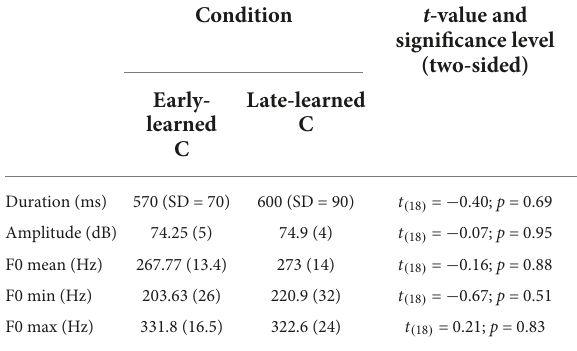
TABLE 2 Experiment 1: acoustic characteristics of the